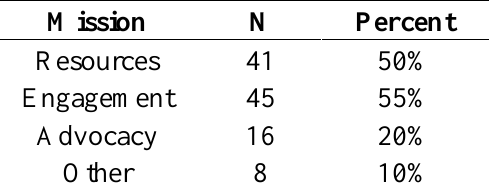
Table 4. PTG mission